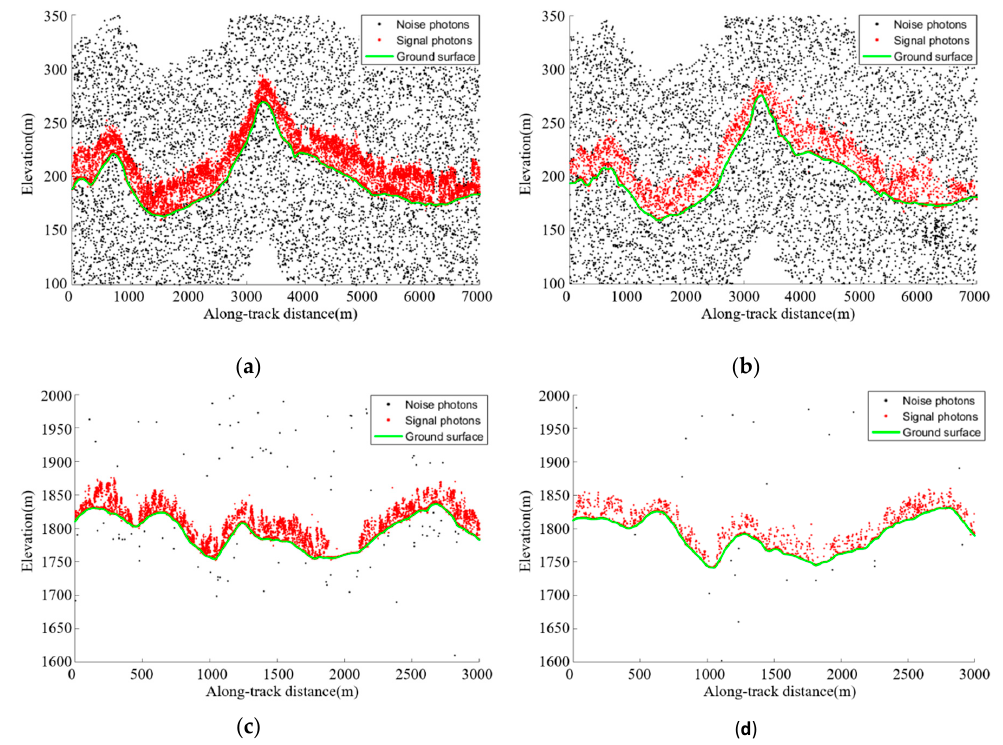
Figure 4. The qualitative results of ground surface (green line) retrieved from four different scenarios of ICESat-2 data: ( a ) strong beams of ICESat-2 in the daytime, ( b ) weak beams of ICESat-2 in the daytime, ( c ) strong beams of ICESat-2 in the nighttime, and ( d ) weak beams of ICESat-2 in the nighttime. Table 1. The statistical errors of ground elevation using four different scenarios of ICESat-2 data.